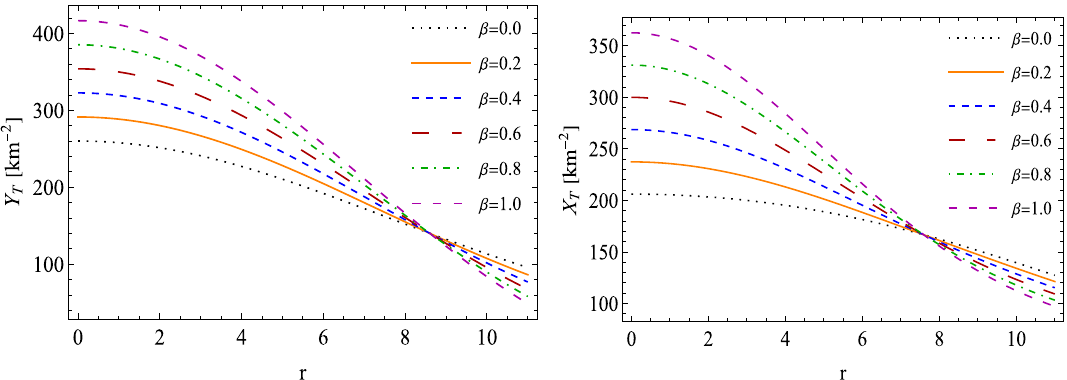
Fig. 7 The behavior of scalars Y T × 10 4 -left panel and X T × 10 4 -right panel describe the strong energy condition and homogeneous energy density distribution versus r for isotropic solution 5.2. We set same numerical values as used in Fig.5